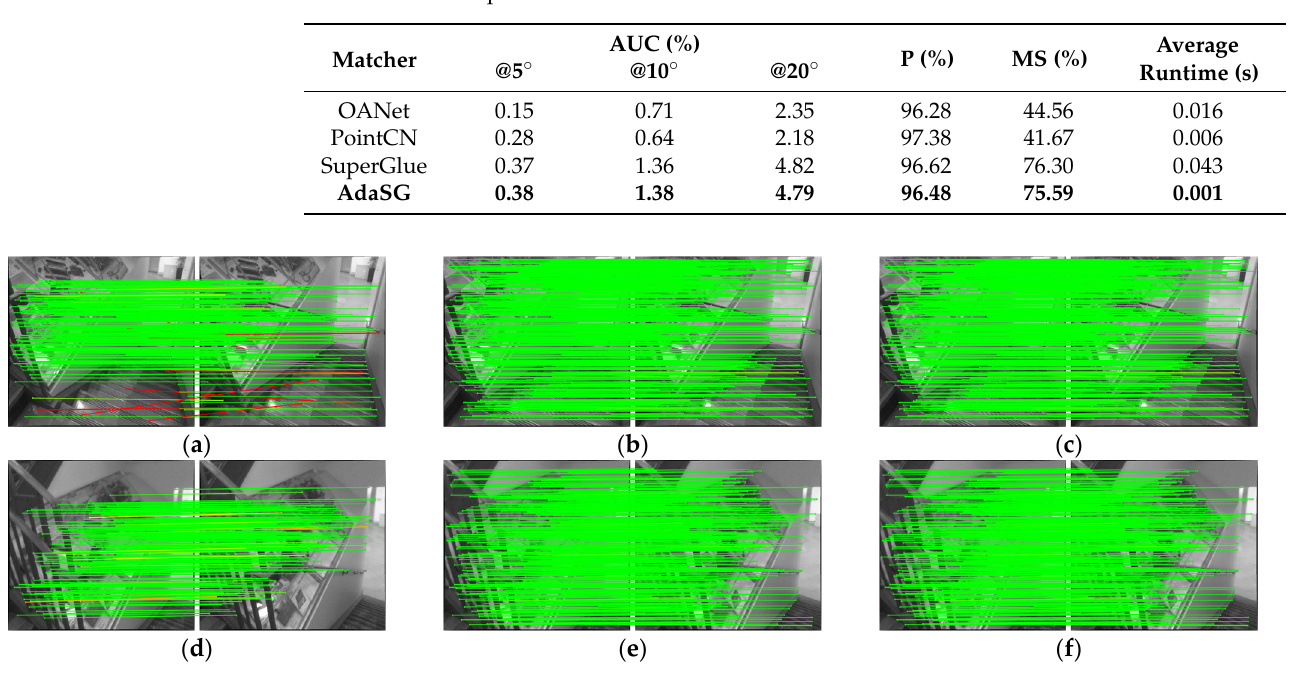
Figure 9. The visualized matching result on Scannet. The red lines represent mismatches, and the green lines represent correct matching. ( a ) The results of OANet. ( b ) The results of SuperGlue. ( c ) The results of AdaSG. ( d ) The other results of OANet. ( e ) The other results of SuperGlue. ( f ) The other results of AdaSG.